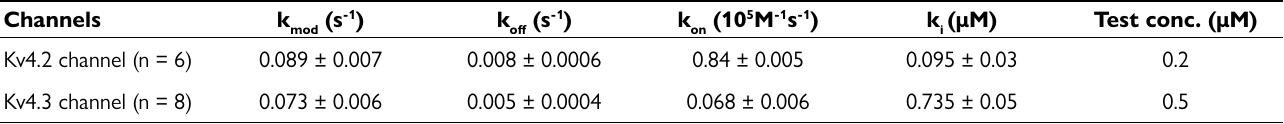
Table 2. Interactions between JZTX-X and voltage-gated potassium channels